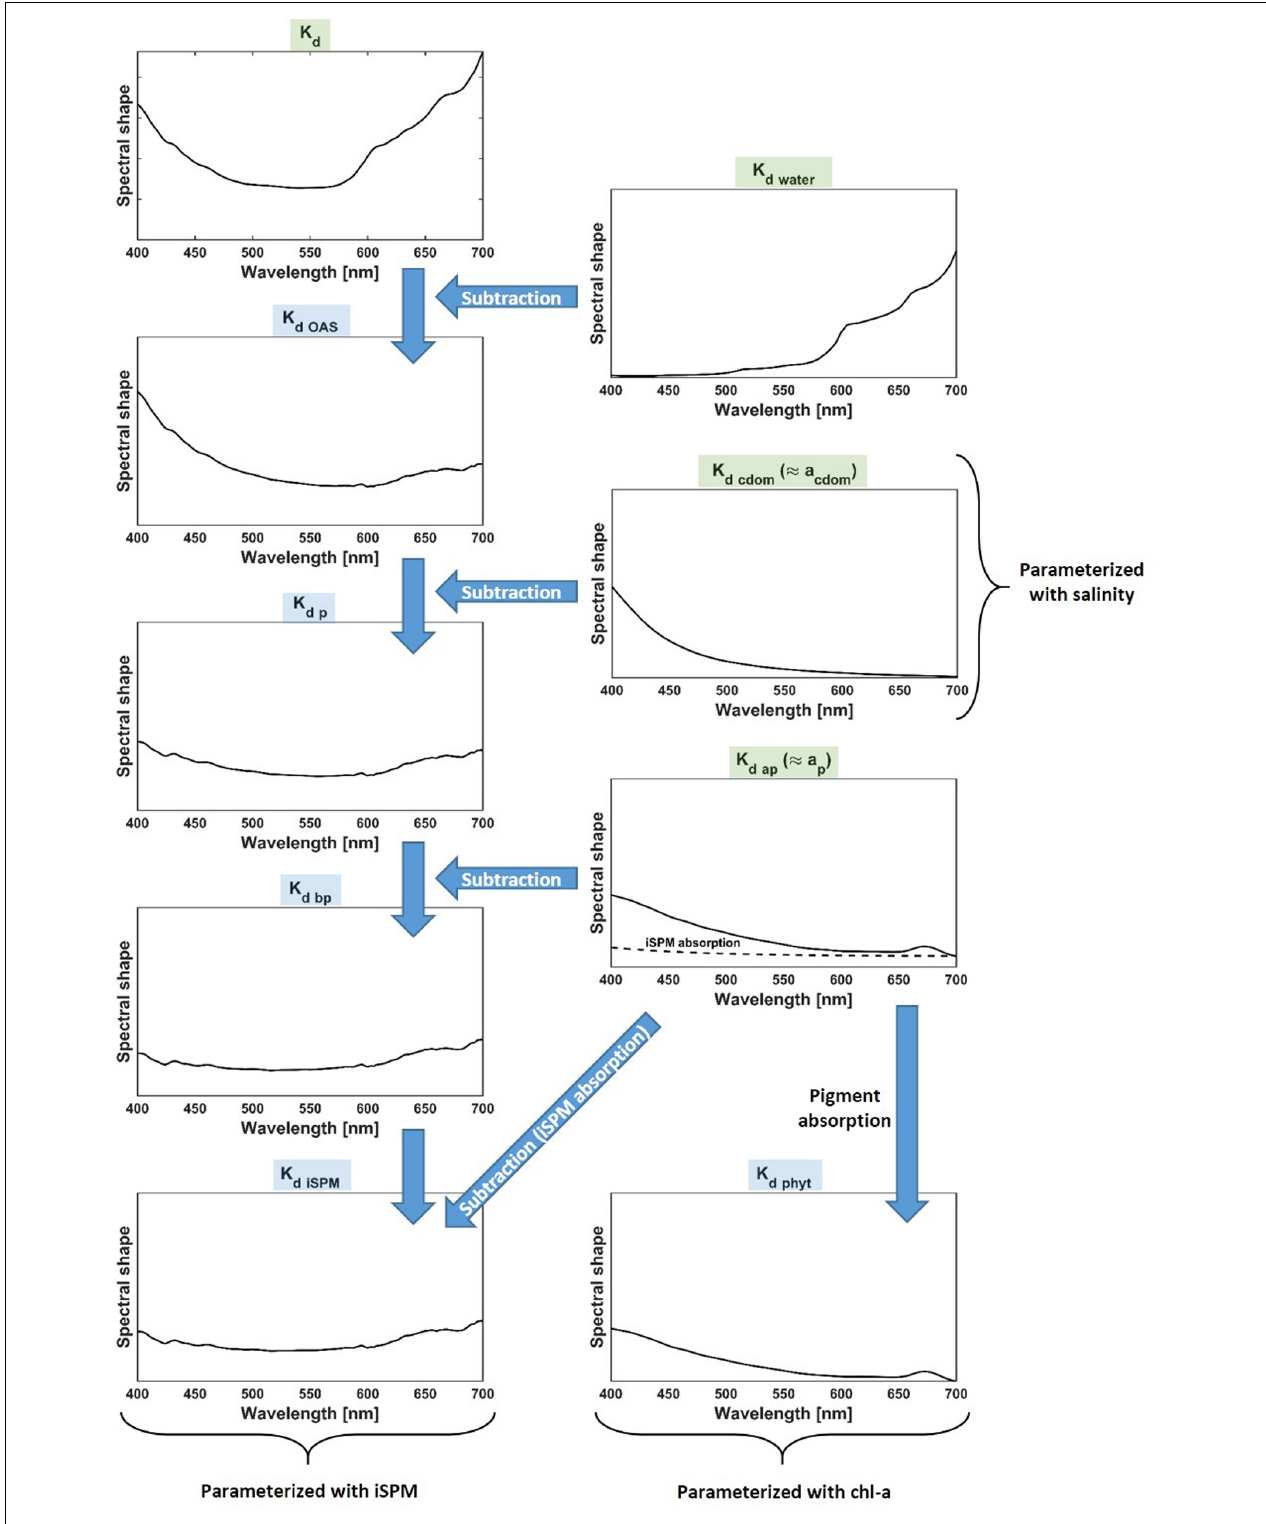
FIGURE 2 | Decomposition of K d ( λ ) in spectra associated to the various optically active constituents [ K d water ( λ ), K d cdom ( λ ), K d phyt ( λ ), and K d iSPM ( λ )]. The arrows indicate which parameter has been taken into account for deriving the respective decomposition step. Parameters highlighted in green originate from measurements, while the parameters highlighted in blue are derived from the decomposition.